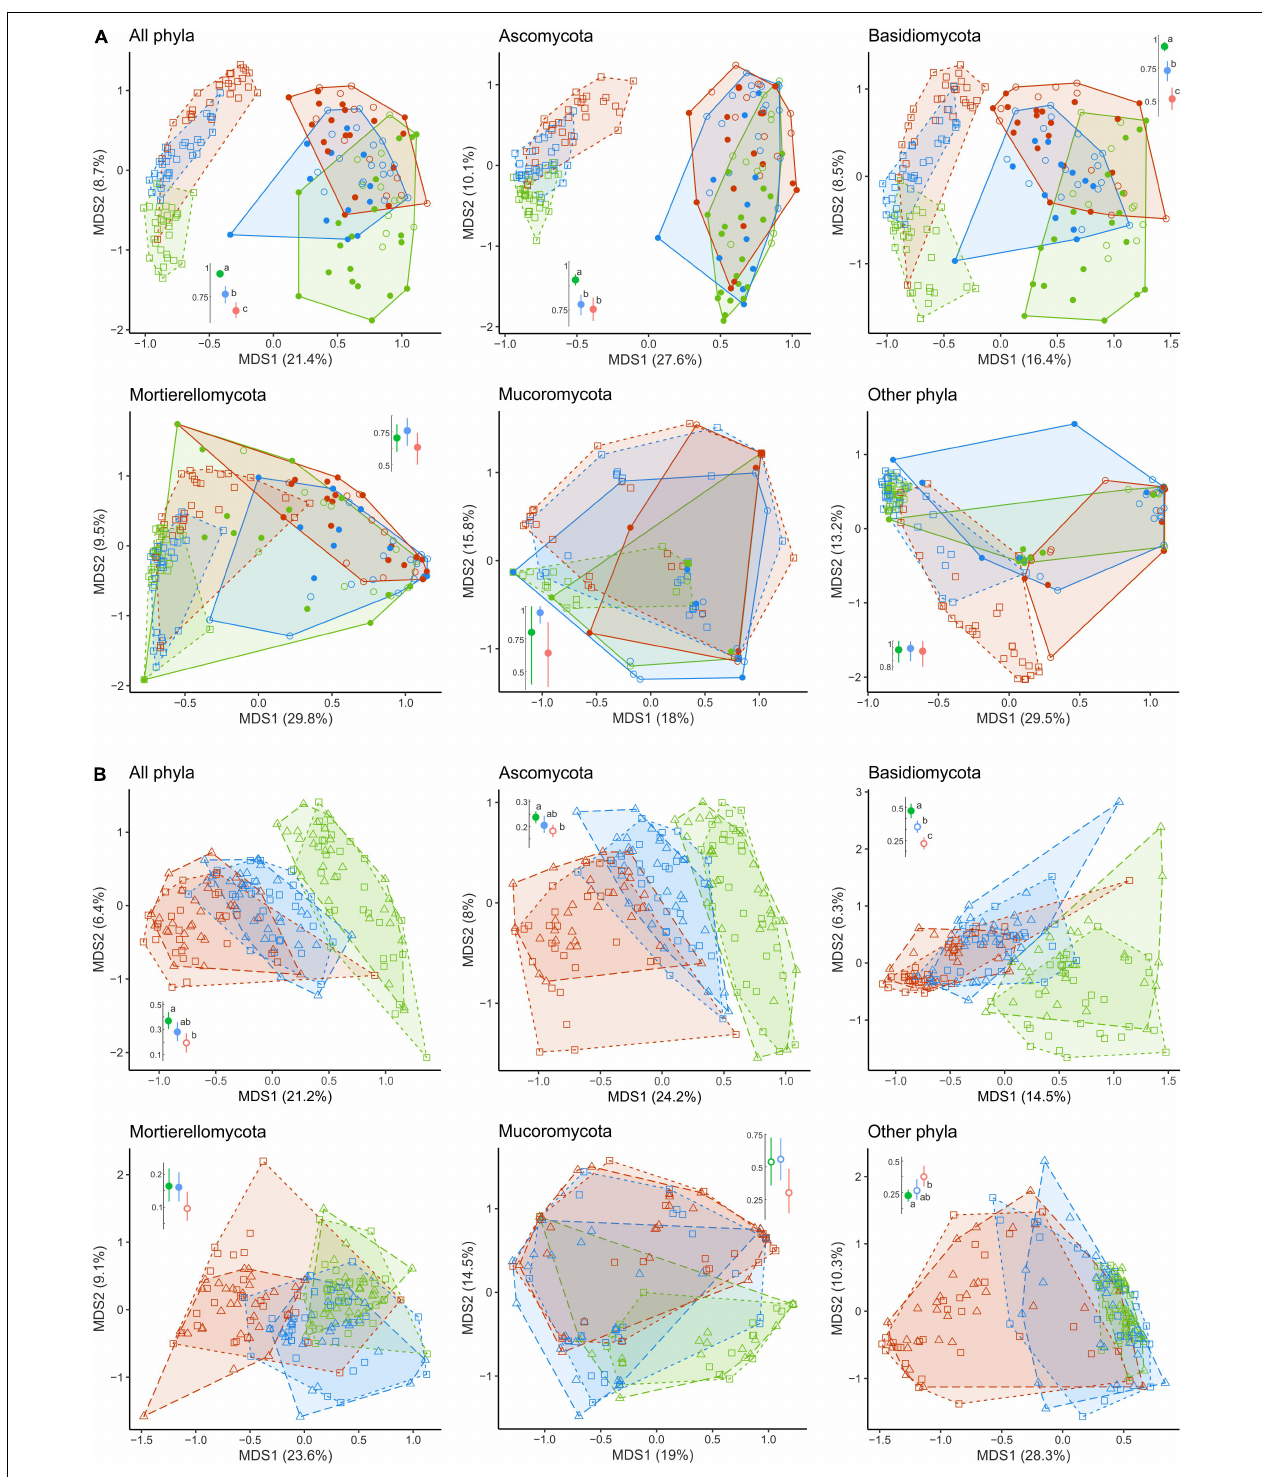
FIGURE 6 | Compositional dissimilarity of fungal communities of CWD-uninfluenced litter from (A) wood and (B) CWD-influenced litter in the areas with different levels of pollution (green, UP area; blue, MP area; red, HP area). Filled circles denote fir wood; empty circles, spruce wood; squares, forest litter far from CWD; triangles, forest litter close to CWD. Average dissimilarity values with 95% CI are shown next to each ordination diagram: filled dots indicate statistically significant compositional divergence between microhabitats within an area (PERMANOVA test, p < 0.05). Different letters indicate significant differences of within-area dissimilarity between the areas (Tukey’s test, p < 0.05). CWD, coarse woody debris; UP, unpolluted; MP, moderately polluted; HP, heavily